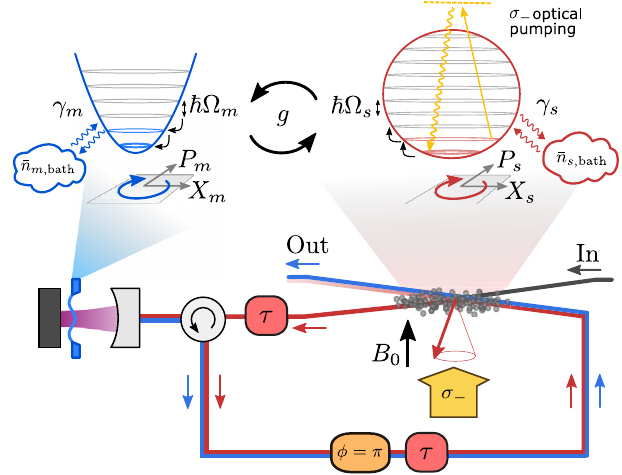
FIG. 1. Sketch of the light-mediated spin-membrane coupling. Light interacts first with the spin, then with the membrane, and then again with the spin. The propagation of the light leads to a feedback delay τ . On the way back from the membrane to the spin, a π phase is imprinted on the light, rendering the spin- membrane interaction effectively Hamiltonian for zero delay τ ¼ 0 . The systems can be approximated by harmonic oscillators of frequencies Ω and Ω with damping rates γ and γ coupling m s m s them to a bath with ¯ n and ¯ n phonons, respectively. The m; bath s; bath oscillators are coupled at a rate g . The spin damping rate can be increased by applying a σ − -polarized pumping